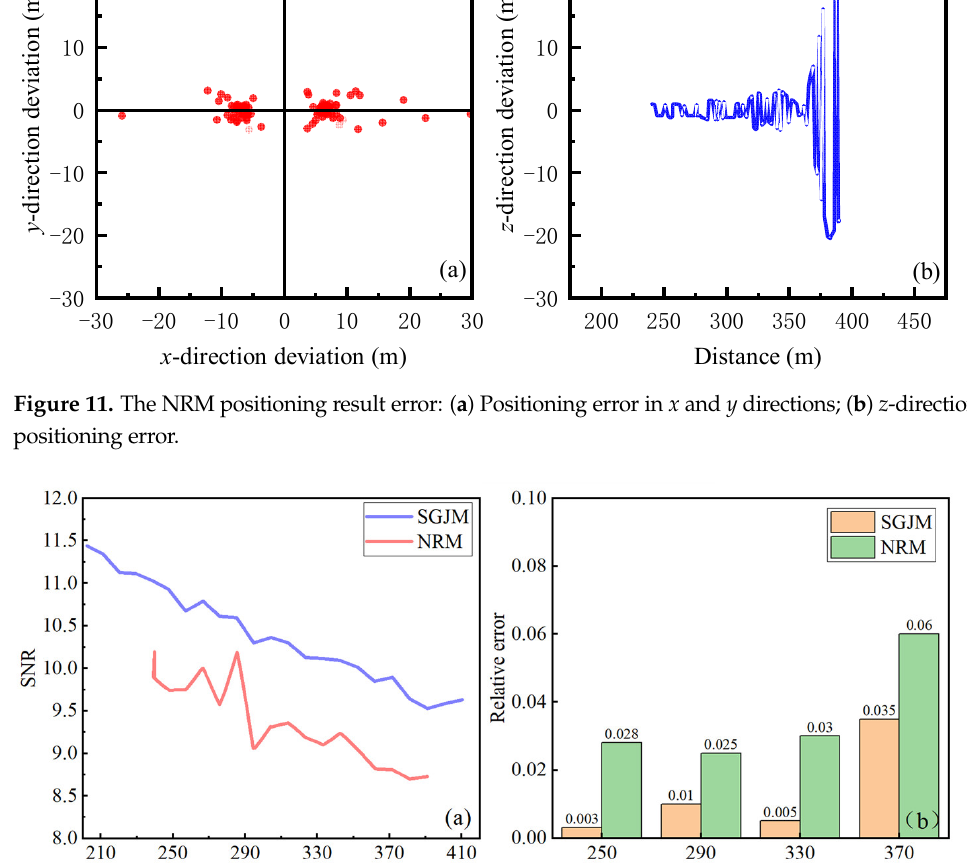
Figure 13. Comparison of RE between NRM and SGJM. According to Table 5, both MAE and RMSE of SGJM are smaller than NRM is, the MAE and RMSE of SGJM in the y direction are slightly beer than NRM is, and the MAE and RMSE of SGJM in the x direction and z direction are obviously beer than those of NRM. Among them, the precision in the x direction has been improved by 88%, the preci- sion in the y direction has been improved by 6%, and the precision in the z direction has been improved by 85%. The improvement of positioning accuracy in the y direction is lower because the positioning accuracy of NRM in the y direction is higher. According to Table 6, the positioning accuracy of SGJM is beer than that of NRM in x and z directions. There is no significant difference in the positioning results in the y direction. According to Figures 10 and 11, the positioning error of SGJM is obviously beer than that of NRM. The positioning error of SGJM increases with the increase in distance, but it is still within the range of − 4~4 m. According to Figure 12a, with the increase in distance, the SNR decreases, and the influence of environmental noise increases. Accord- ing to Figures 12b and 13, the RE of NRM is less than 6% when the distance is less than 360 m; the RE is less than 4% when the distance of SGJM is less than 410 m, and the RE is 210